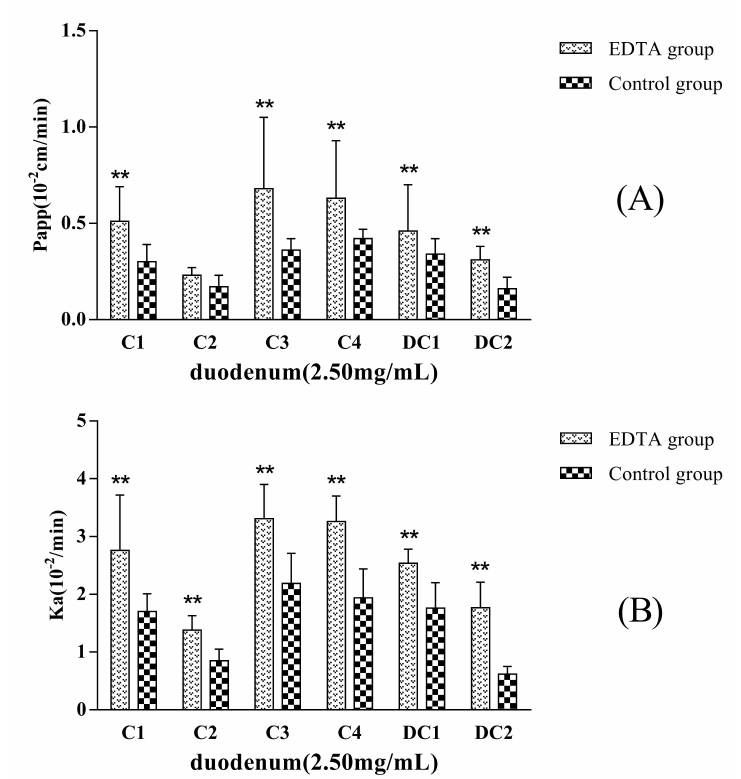
Figure 5. P app ( A ) and K a ( B ) of the six analytes in duodenum obtained after in situ single-pass perfusion of MDQ-TS (2.5 mg/mL) with or without EDTA. The rat duodenum (~10 cm) was used to evaluate the intestinal permeability of MDQ-TS. Data was expressed as mean ± SD of five independent experiments each group. ** p < 0.01 versus non-EDTA